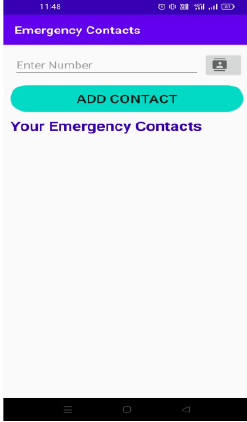
Fig 6. Add emergency contacts from phonebook